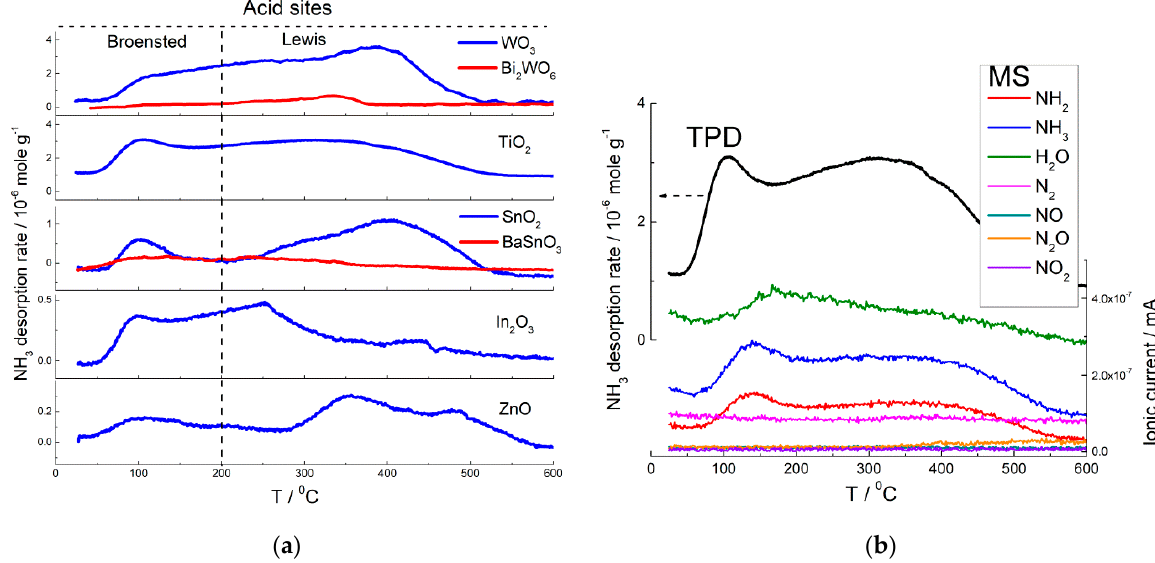
Figure 11. Temperature plots of ammonia desorption rate from the surface of n -type MOS ( a ). Adapted with permissions from ref. [63] copyright 2021 Elsevier; ref. [75] copyright 2018 Elsevier; ref. [78] copyright 2021 Elsevier; ref. [79] copyright 2014 American Chemical Society. TPD pattern of TiO 2 compared with mass-spectral (MS) analysis of desorbed gas ( b ).